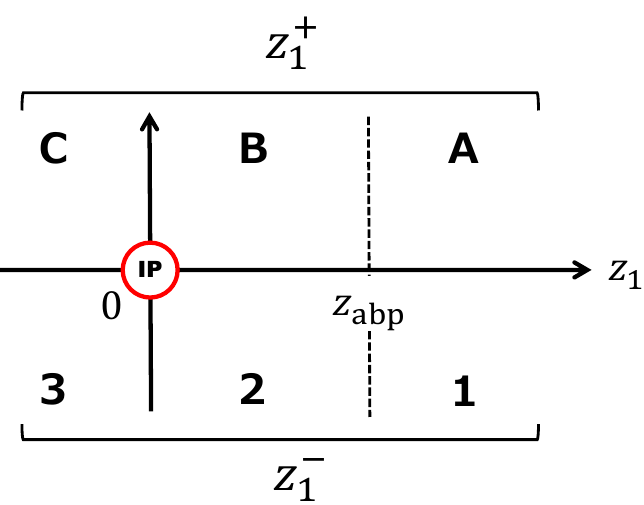
Figure 9 . A schematic view of the z 1 coordinate for the case of the scalar boson decay.